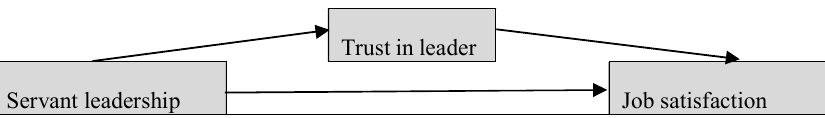
Fig. 1. Theoretical Model: (SL), (JS) and trust towards leader